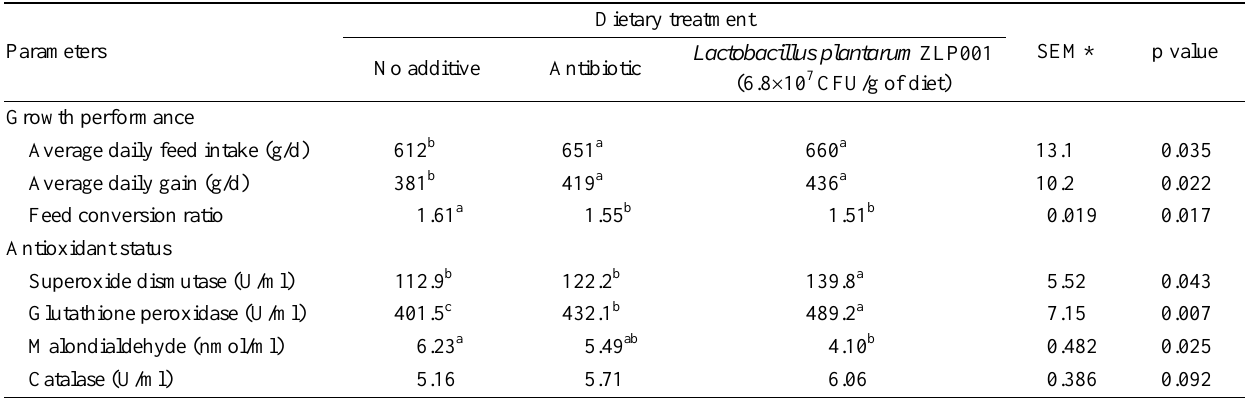
Table 2. Effect of Lactobacillus plantarum ZLP001 supplementation on growth performance of weaning piglets and superoxide dismutase, glutathione peroxidase, malondialdehyde, and catalase concentrations in the serum Parameters